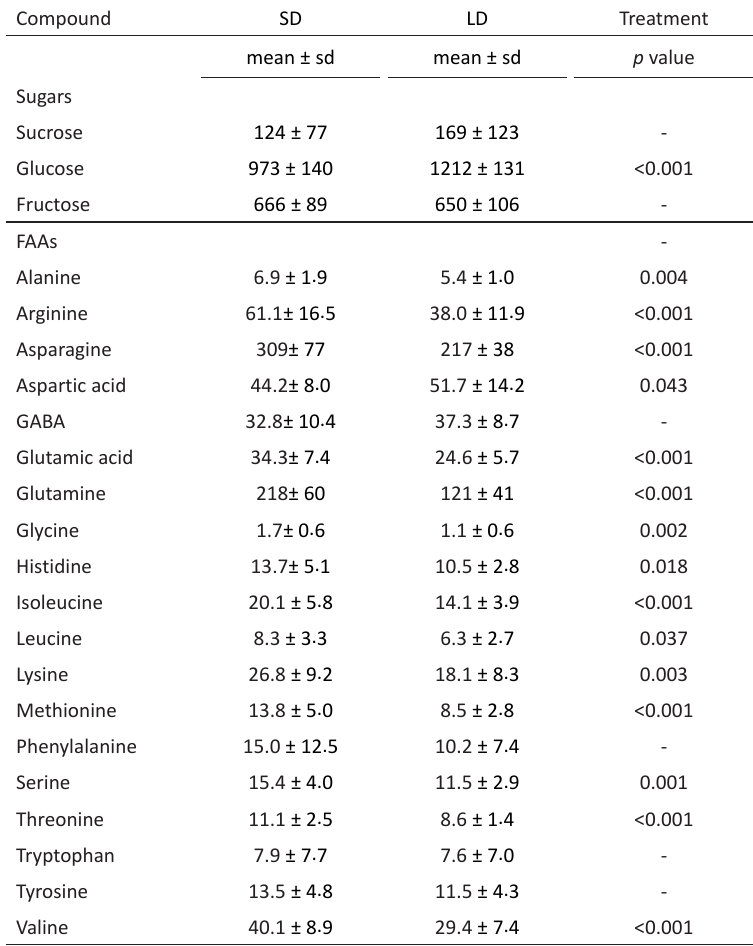
Table 4. Free sugars and amino acids of potato tubers grown in SD and LD photoperiods. Average of seven potato cultivars (with three technical replicates each), in mg 100 g -1 (FW).